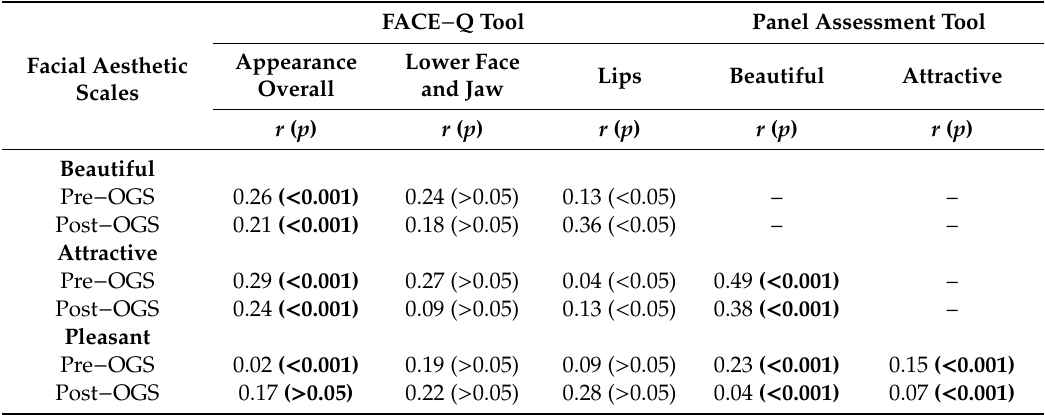
Table 6. Correlations for Pre − and Post − Orthognathic Surgery Assessment Scores of FACE − Q Facial Appraisal Scales and Surgeon − Based Panel Assessment of Facial Aesthetic Scales.